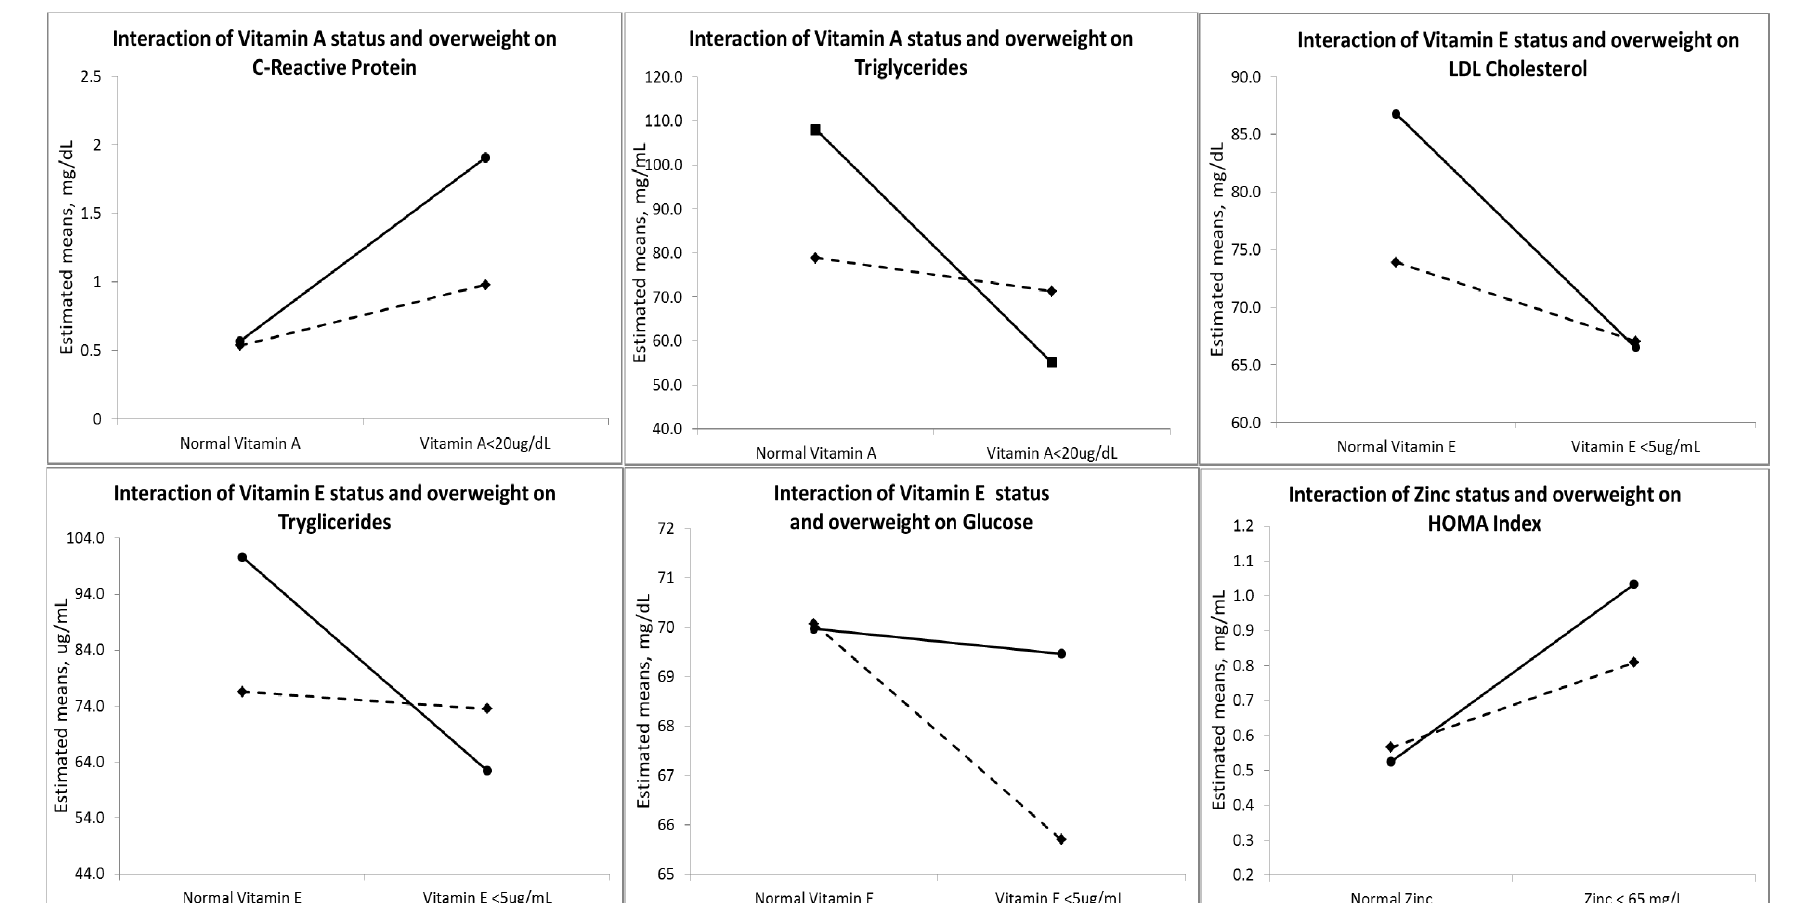
Figure 1. Interaction between being overweight and obesity and micronutrients on C-reactive protein, triglycerides, low-density lipoprotein, glucose and insulin resistance in overweight/obese and normal weight children ( n = 197). Continuous lines represent children with a BMI Z -score > 1 SD, and the dotted lines represent children with a BMI Z -score ≤ 1